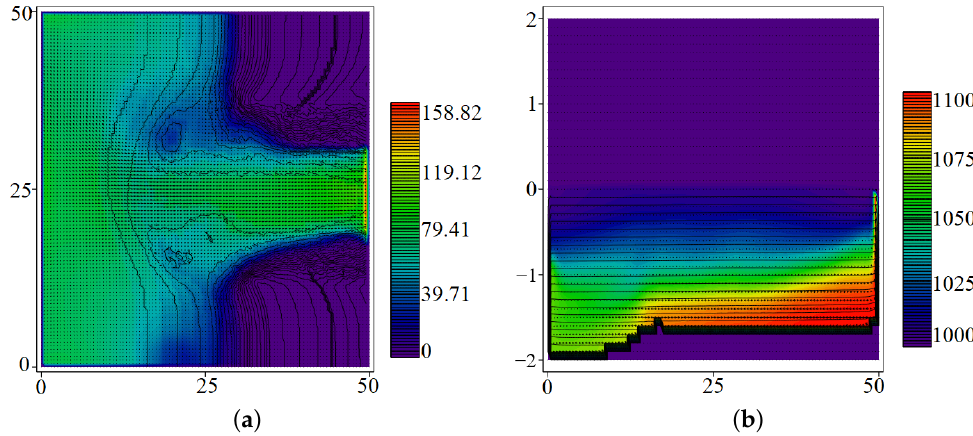
Figure 5. The movement of water and suspended matter in the mouth area after 5 min. ( a ) concentra- tion of suspended matter; ( b ) water